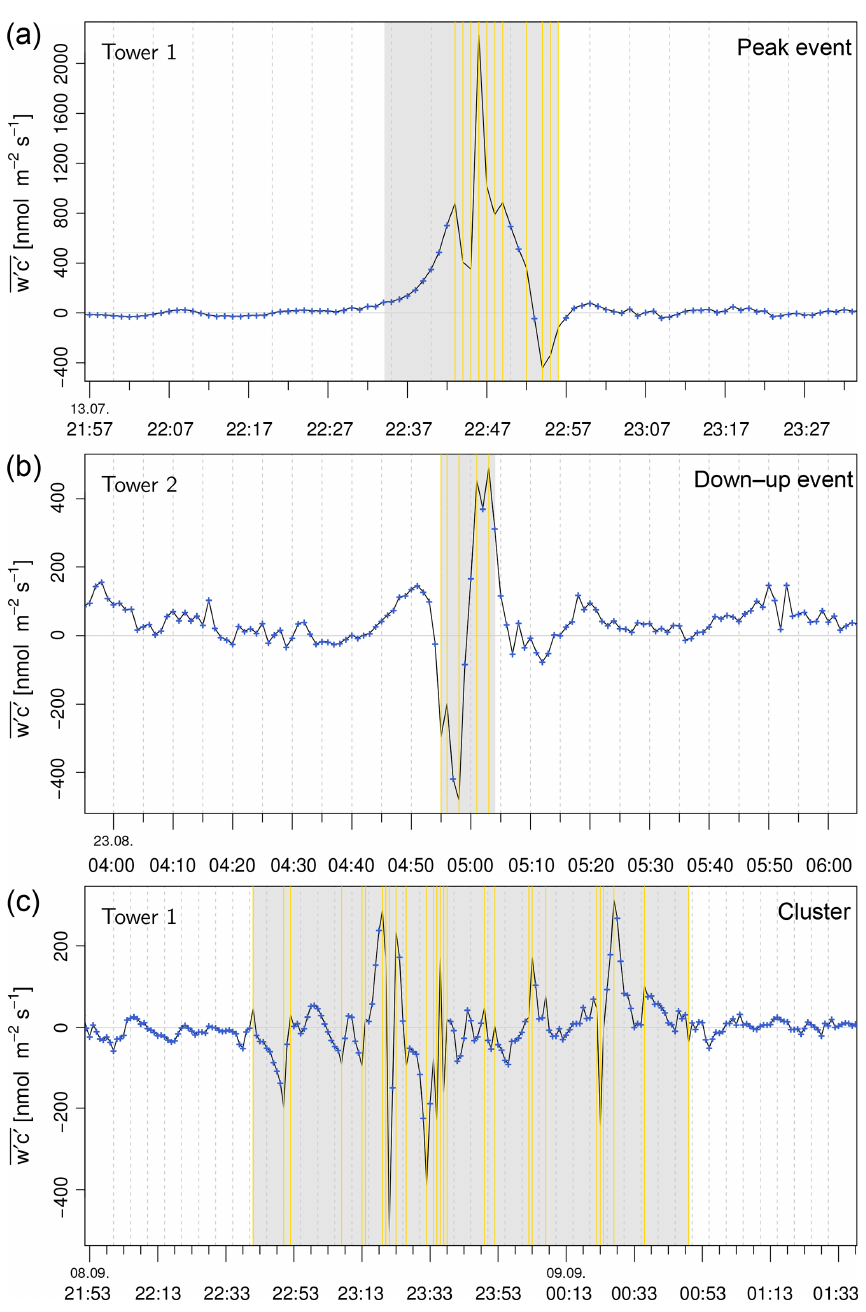
Figure 1. Examples for peak events (a) , down–up events (b) , and clustered events (c) identified using the Mexican hat wavelet flux. Data points marked with a yellow vertical line were detected as event minute using the MAD test with threshold q = 6, while all other non-event data were marked with blue plus signs. The manually detected event length is shaded in grey